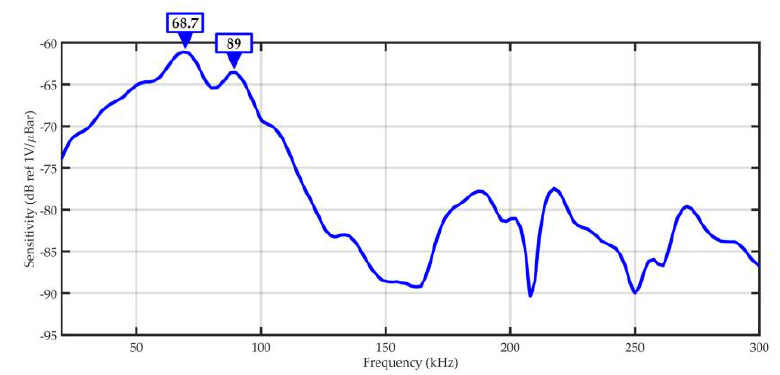
Figure 20. The frequency response curve of the prototype AE sensor type A6890.